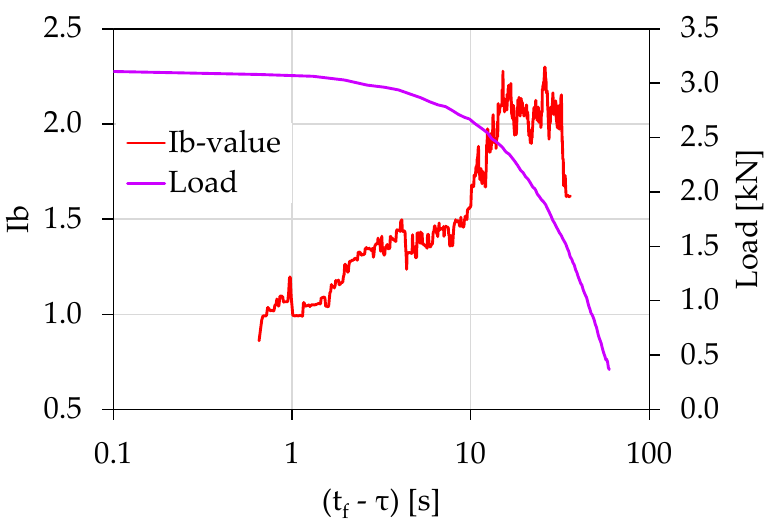
Figure 12. The temporal evolution of the Ib -value in juxtaposition to the load applied for the experiment Exp-HR in terms of the “time-to-failure” parameter.